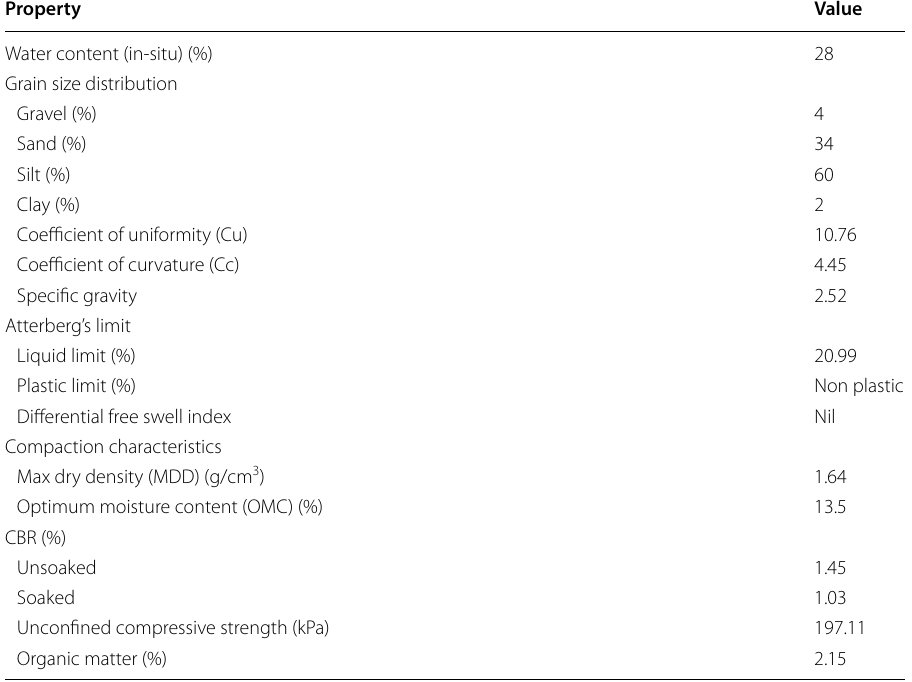
Table 1 Geotechnical properties of dredged soil Property Value Water content (in-situ) (%)